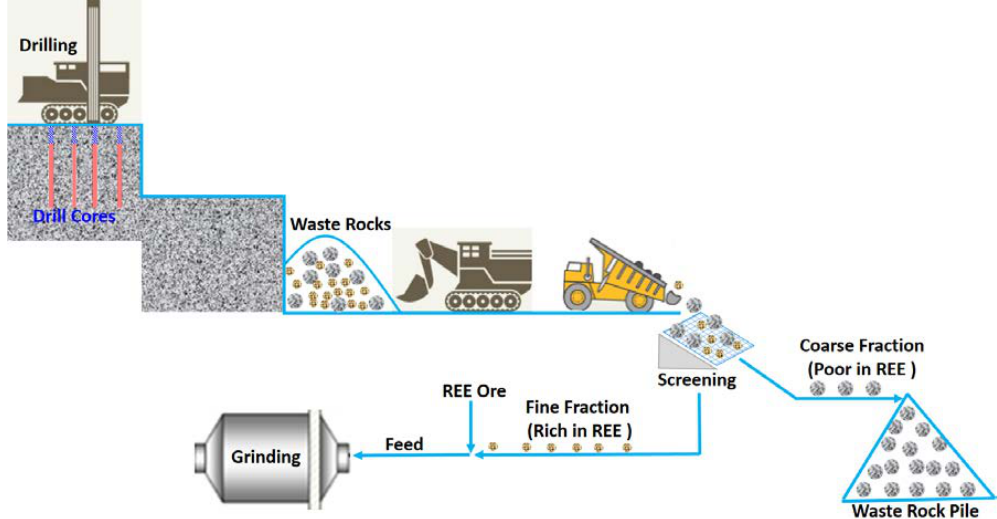
Figure 11. Example of integrated management of REE mine wastes.